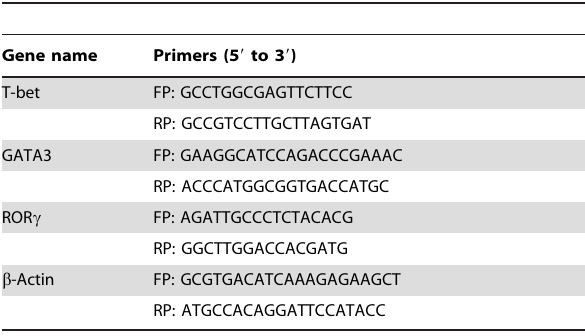
Table 1. The name and primer sequences used in real-time